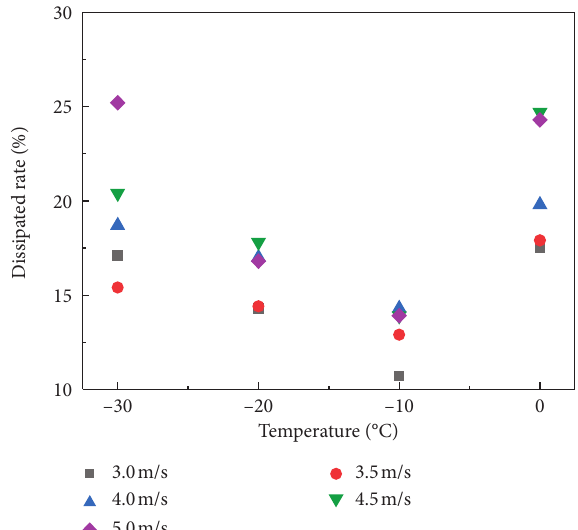
Figure 11: Relationship between energy dissipation rate and temperature.